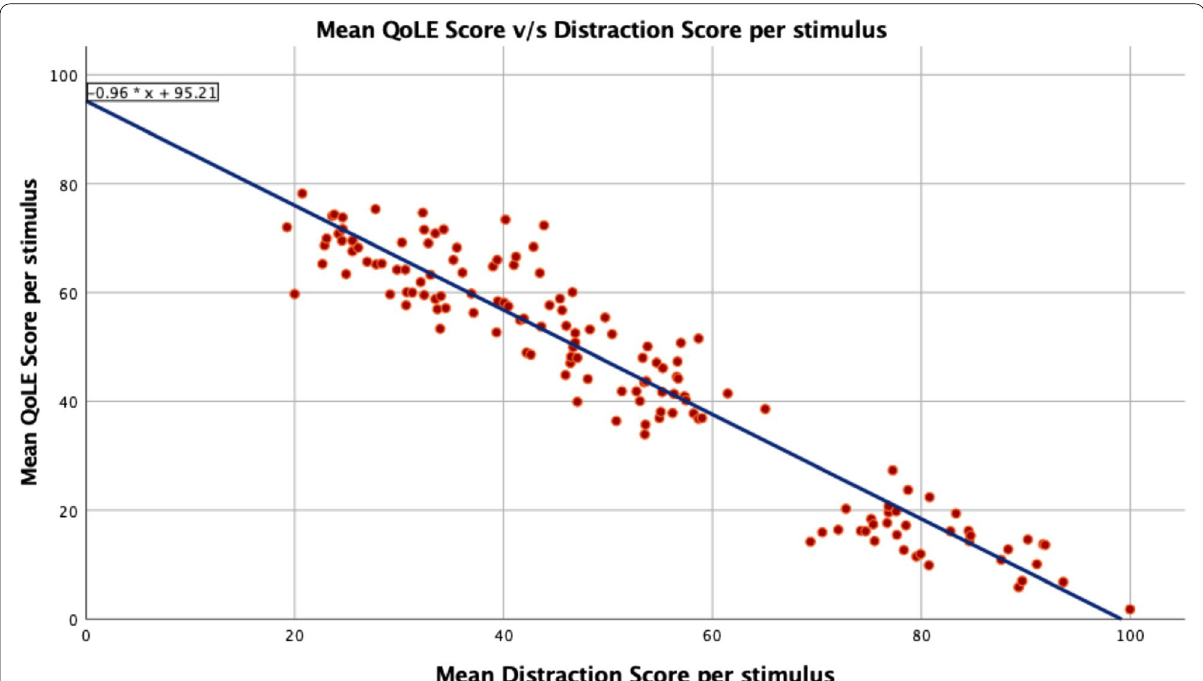
Fig. 4 Scatter plot of the QoLE Score with the distraction rating. The fit line is also visible, indicating that there is a negative, but linear correlation between the QoLE ratings and distraction